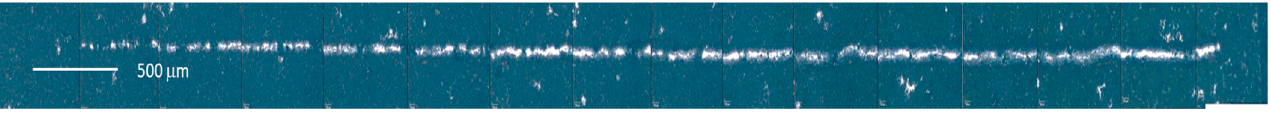
Figure 5. Scratch track of Cr 3 C 2 -NiCr coatings.